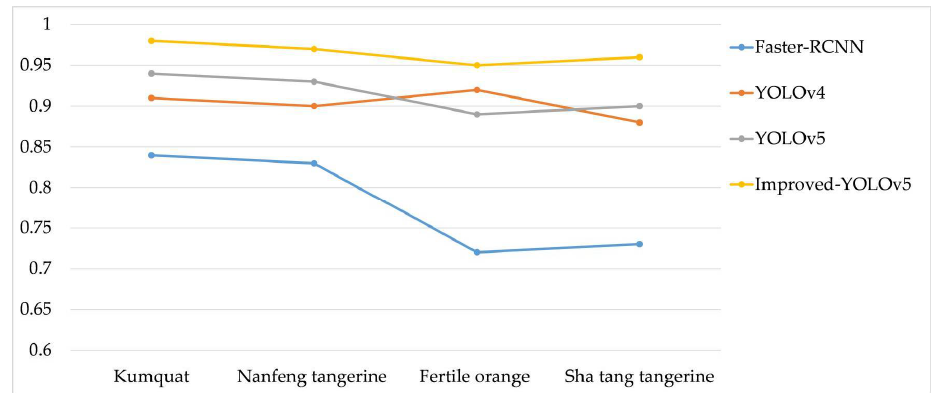
Figure 13. The AP values of the four detection models on the four citrus varieties.